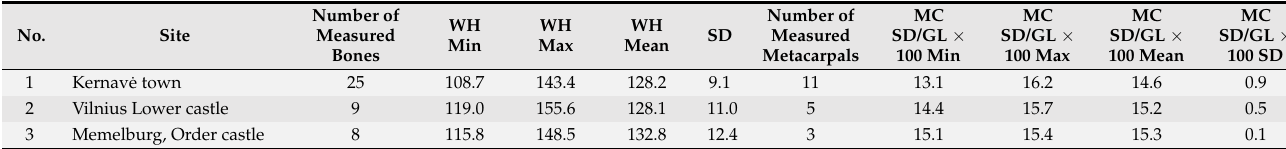
Table 3. Horses from Kernav˙e medieval town and castles